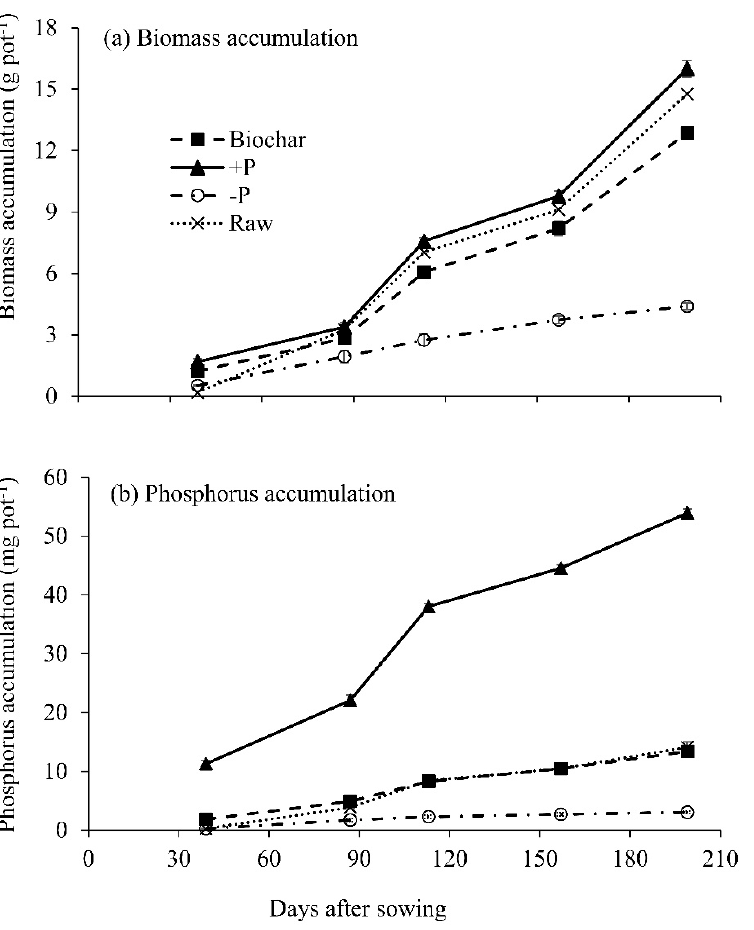
Figure 3. Accumulation of biomass ( a ) and phosphorus ( b ) in ryegrass plants for five harvests up to 200 days after sowing. Error bars indicate SEM ( n = 4).